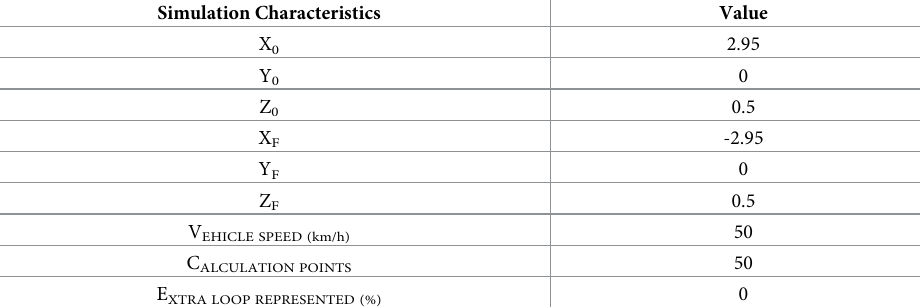
Table 3. Citroe¨n AX simulation